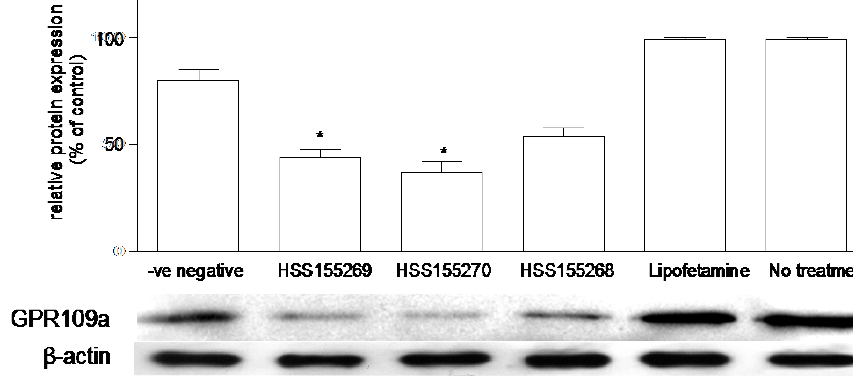
Figure 6. Cont Figure 6. Cont. Figure 6. Cont.